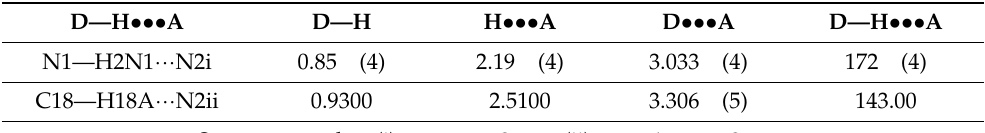
Figure 1. ( a ) XRD for 4 which was plotted using ORTEP, non-H atoms, represented by ellipsoids (50% probability level). ( b ) Three-dimensional networks for molecular packing. H-bonds are represented in dashed lines. Table 1. The geometry for the H-bond (Å, ◦ ) for compound 4